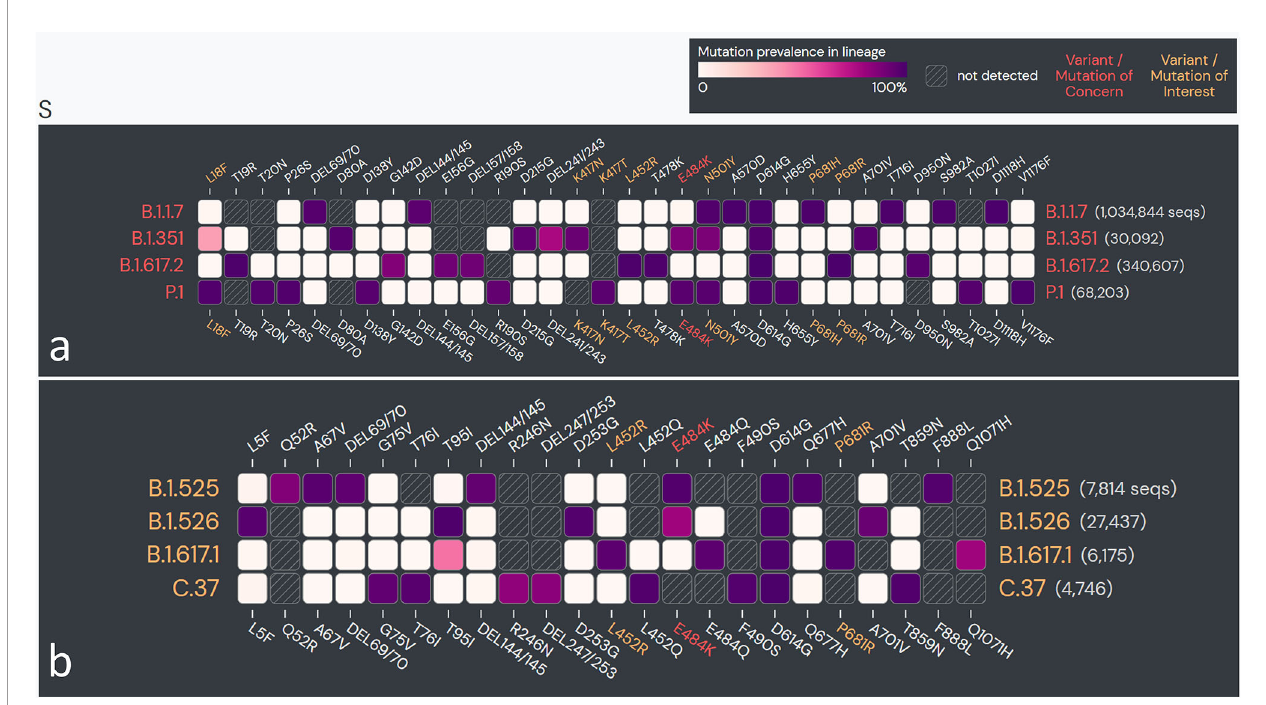
FIGURE 7 | The spike protein coding sequence mutations in emerging severe acute respiratory syndrome coronavirus 2 (SARS-CoV-2) variants globally. (A) Variants of concern (VOCs). (B) Variants of interest (VOIs). [Analysis included mutations with >75% prevalence in at least one lineage currently recognized by World Health Organization (WHO) as variants of concern and variants of interest globally. Data source: www.outbreak.info, accessed on